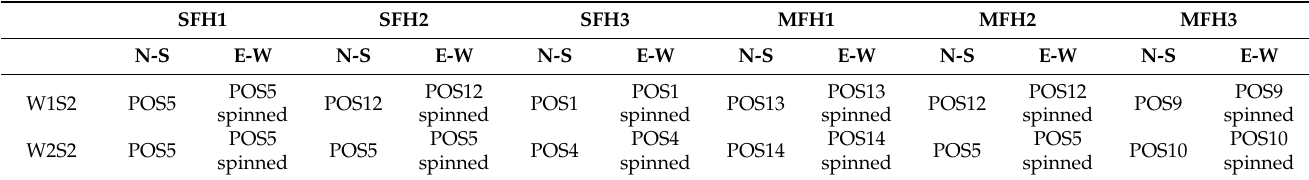
Table 7. POS according to the type of building and orientation, and climate zone in Comunitat Valenciana